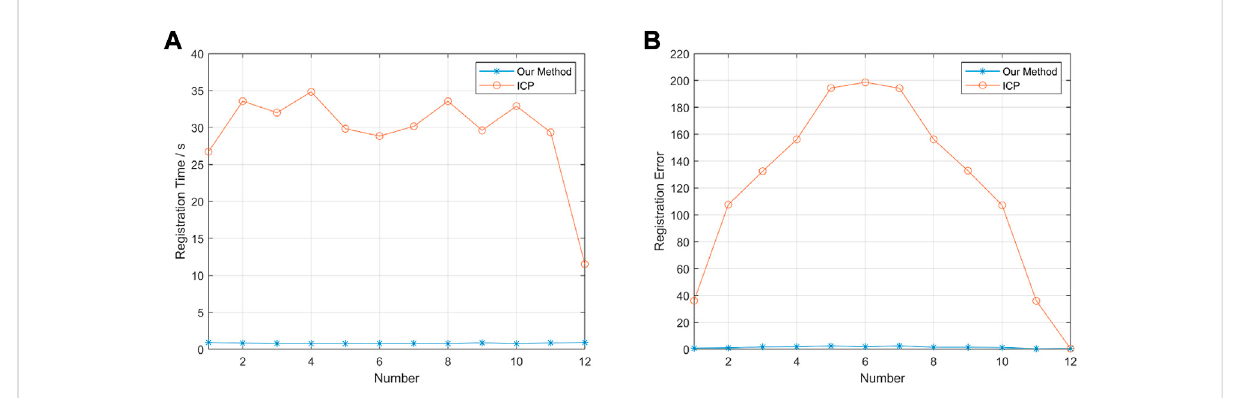
FIGURE 4 Comparison of results: (A) point cloud registration time, (B) registration error.